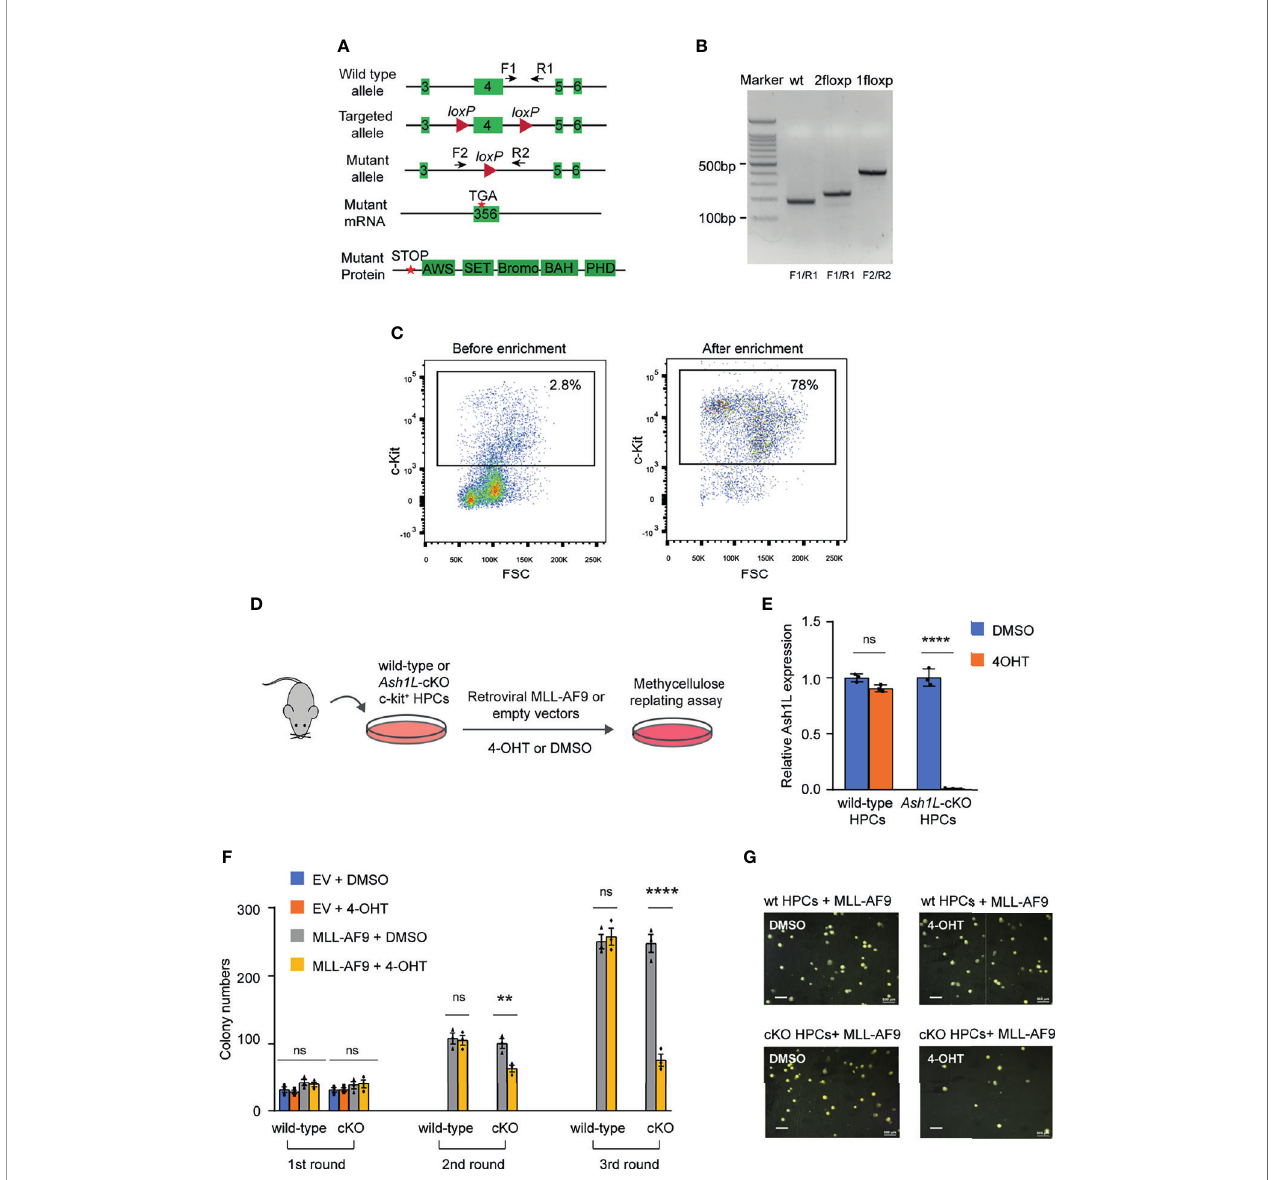
FIGURE 1 | ASH1L is required for the initiation of MLL-AF9-induced leukemic transformation. (A) Diagram showing the strategy for the generation of Ash1L conditional knockout mice. CRE-mediated deletion of exon 4 results in an altered spliced mRNA with a premature stop codon, which generates a truncated protein without all functional AWS, SET, Bromo, BAH and PHD domains. The arrows labeled as F and R represent the genotyping primers. (B) Genotyping results showing the PCR results of wild-type, 2 fl oxP, and 1 fl oxP alleles. (C) FACS analysis showing the c-KIT+ HPC populations before and after enrichment with c-KIT antibody- conjugated beads. (D) Schematic experimental procedure. (E) qRT-PCR analysis showing the Ash1L expression levels in wild-type and Ash1L -cKO cells after treated with 4-OHT or DMSO. The results were normalized against levels of Gapdh and the expression level in DMSO-treated cells was arbitrarily set to 1. The error bars represent mean ± SEM, n = 3 per group. **** P < 0.0001, ns, not signi fi cant. (F) Methylcellulose replating assays showing the colony numbers for each round of plating. The error bars represent mean ± SEM, n = 3 per group. ** P < 0.01; **** P < 0.0001, ns, not signi fi cant. (G) Photos showing the representative colony formation on methylcellulose plates for each group. Bar = 0.5